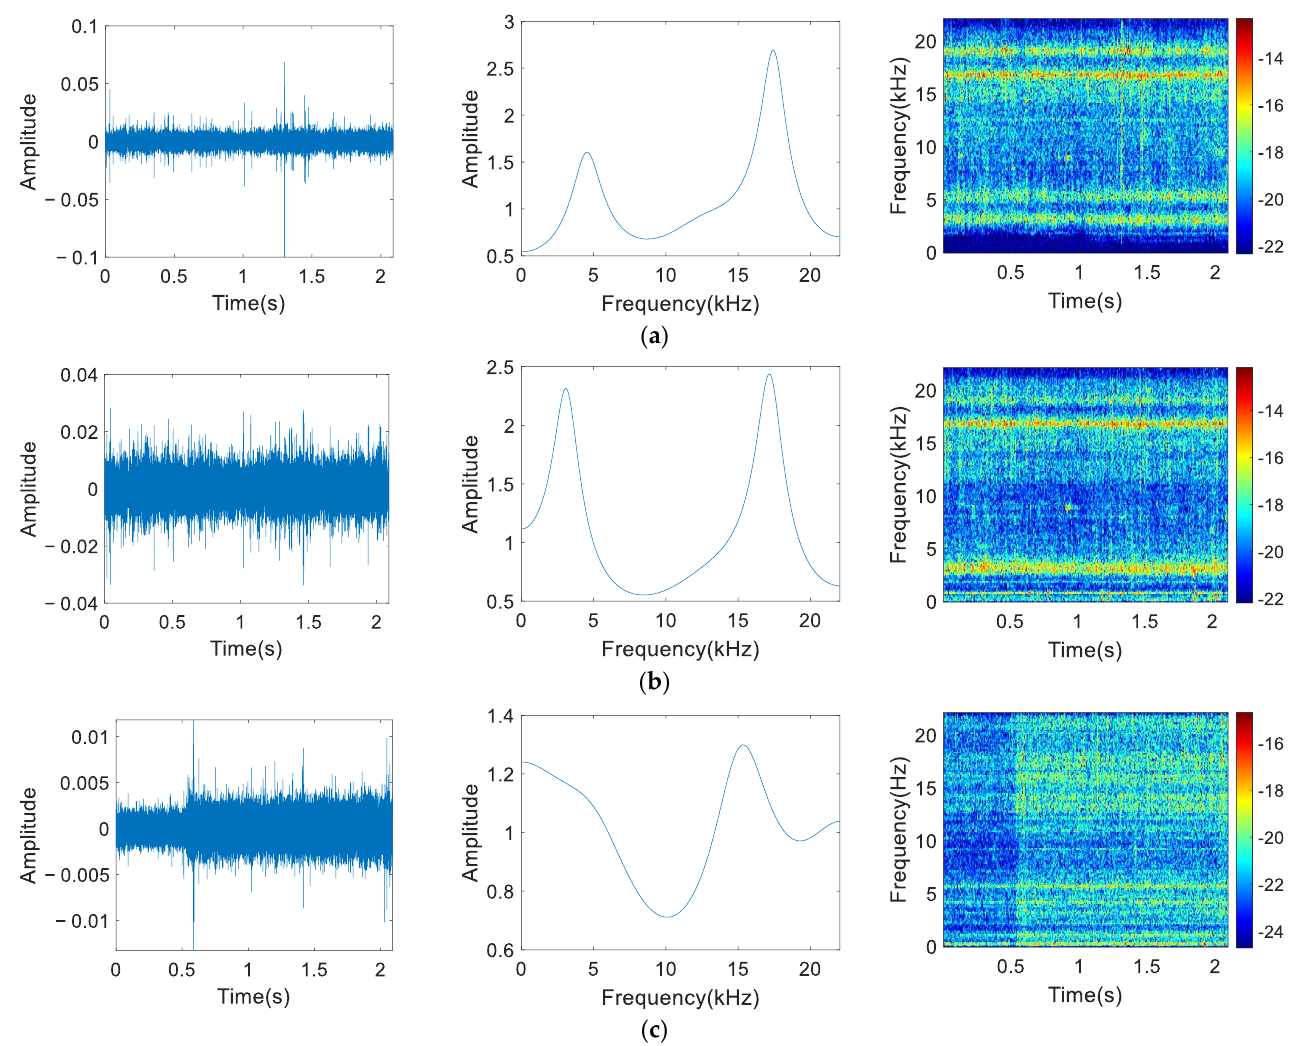
Figure 5. The waveform, linear prediction and spectrogram of the acoustic signal: ( a ) ‘Signal a’; ( b ) ‘Signal b’; ( c ) ‘Signal c’. Table 4. Characteristic vector of ‘Signal a’ , ‘Signal b’ and ‘Signal c’.